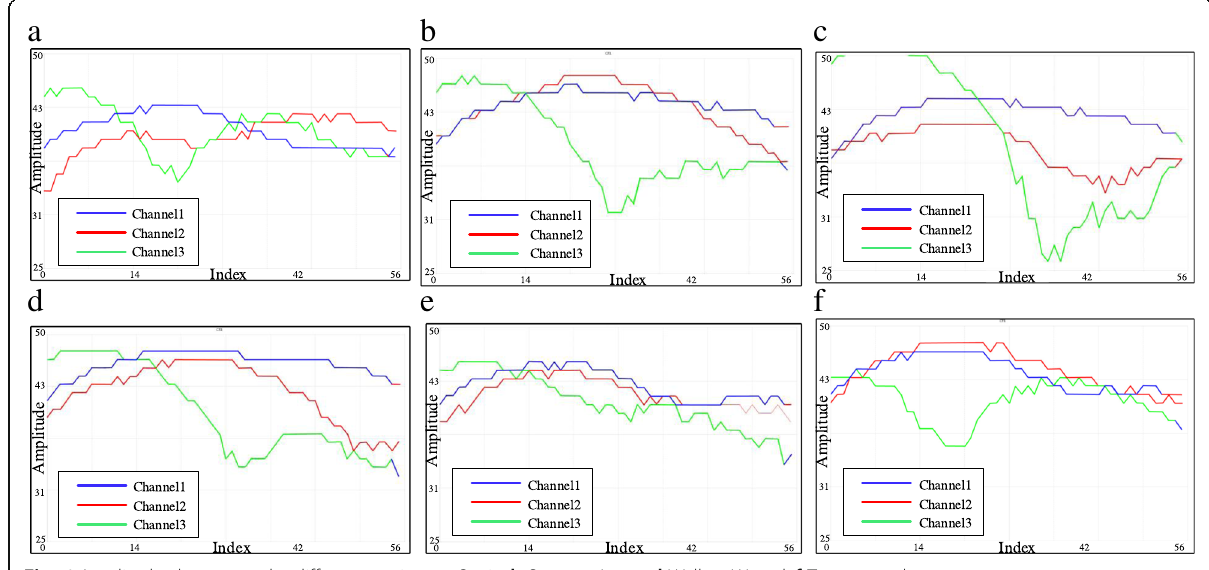
Fig. 6 Amplitude changes under different motions. a Static. b Squat. c Jump. d Walk. e Waved. f Turn around